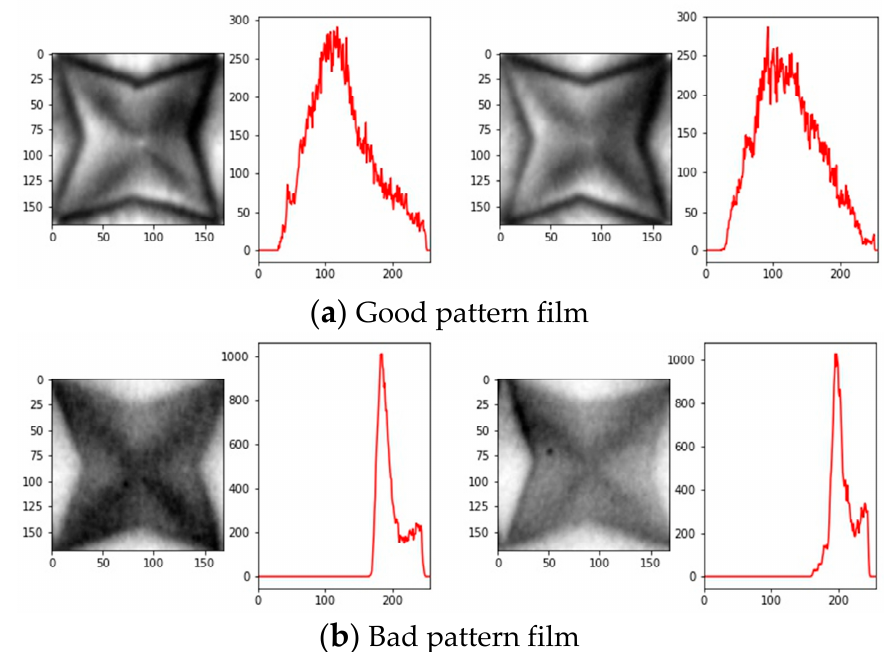
Figure 7. Good and bad 3D film images with image histogram. Table 1. Classification accuracy according to the height of the image histogram.